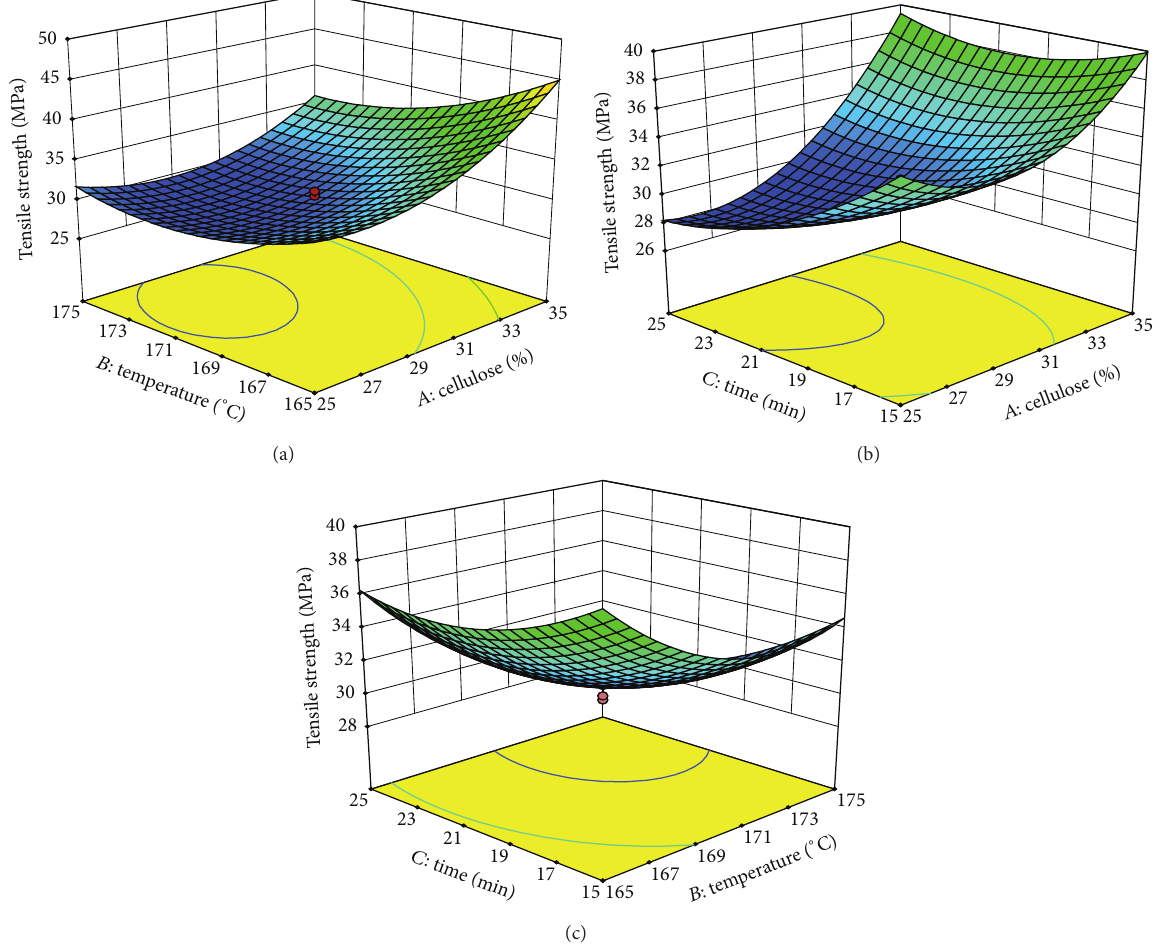
Figure 4: Response surfaces plots of the combined effects of the independent variables on tensile strength of